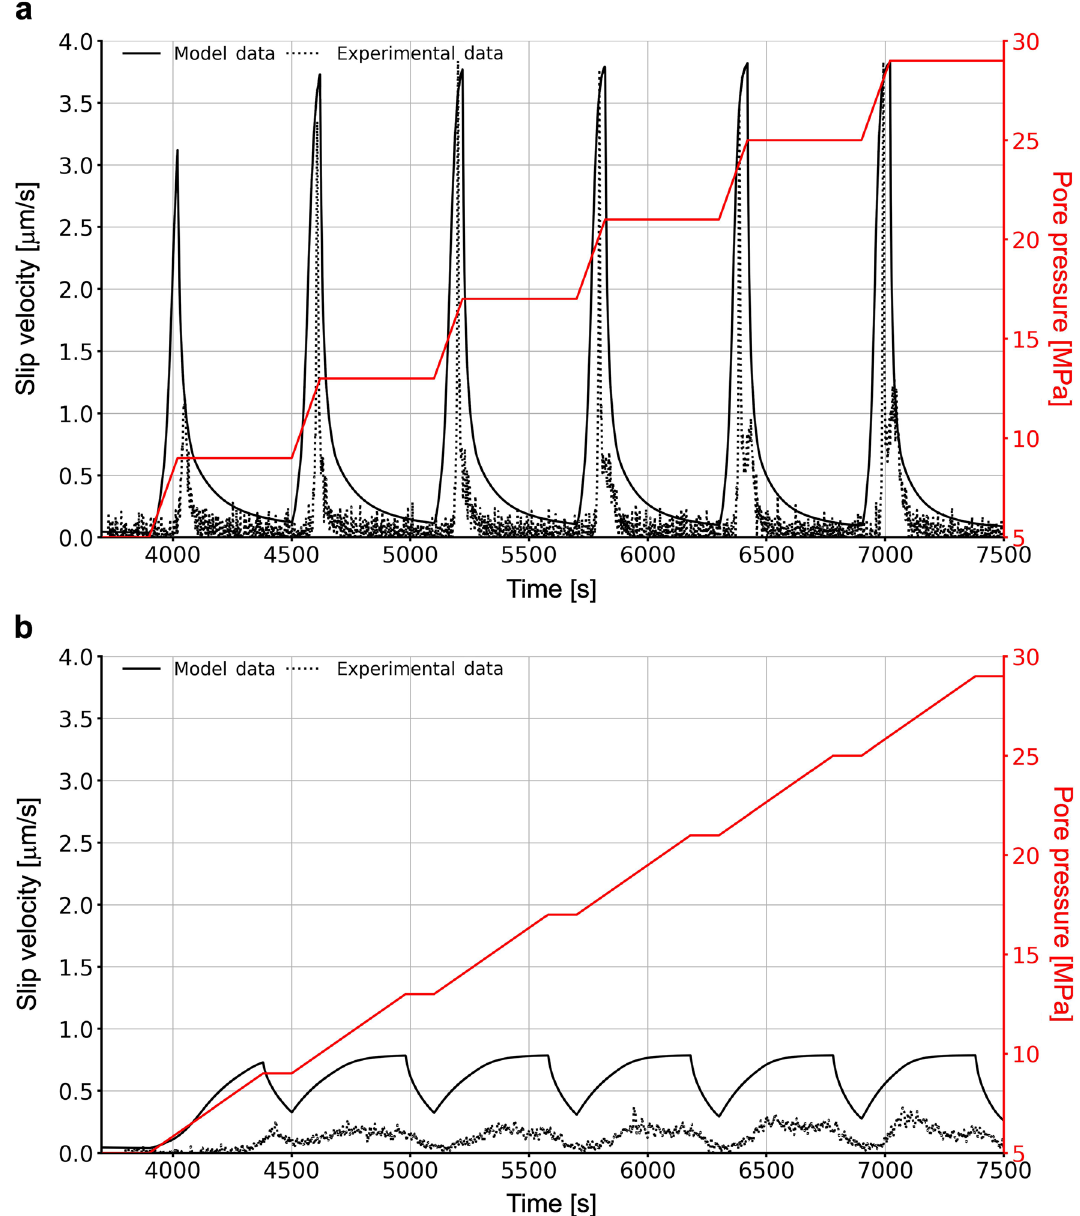
Figure 2. Measured and simulated slip velocity ( a ) for test SC1 with a pressurization rate of 2 MPa/min; ( b ) for test SC2 with a pressurization rate of 0.5